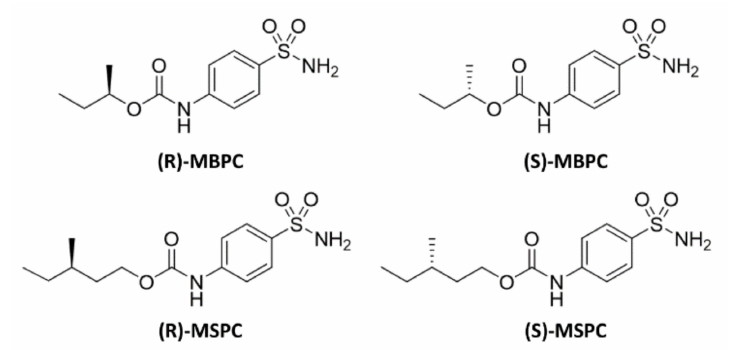
Figure 1. Chemical structures of the individual enantiomers of 3-methylpropyl(4-sulfamoylphenyl) carbamate (MBPC) and 3-methylpentyl(4-sulfamoylphenyl)carbamate